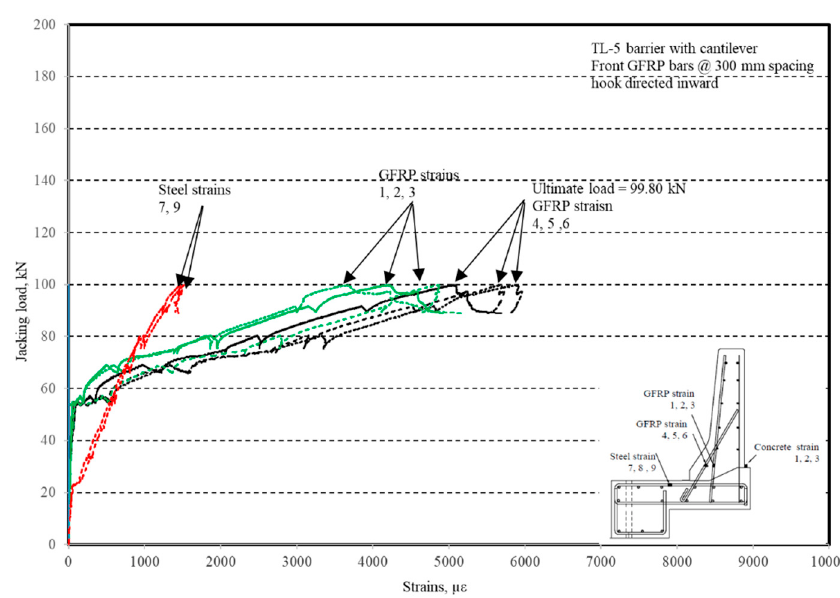
Figure 12. Specimen # 1: Load vs. bar strain history.